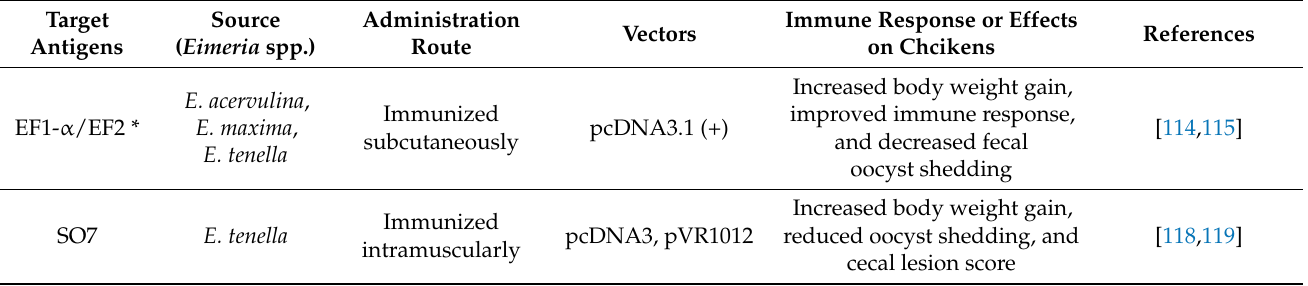
Table 1. Recombinant vaccines against coccidiosis in